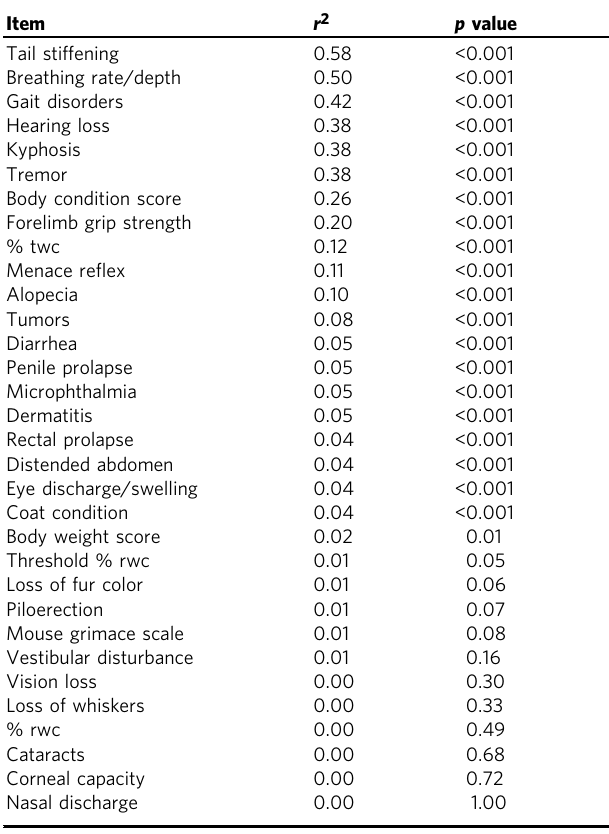
Table 2 Correlation coef fi cients ( r 2 ) and p values for frailty items with chronological age. Item r